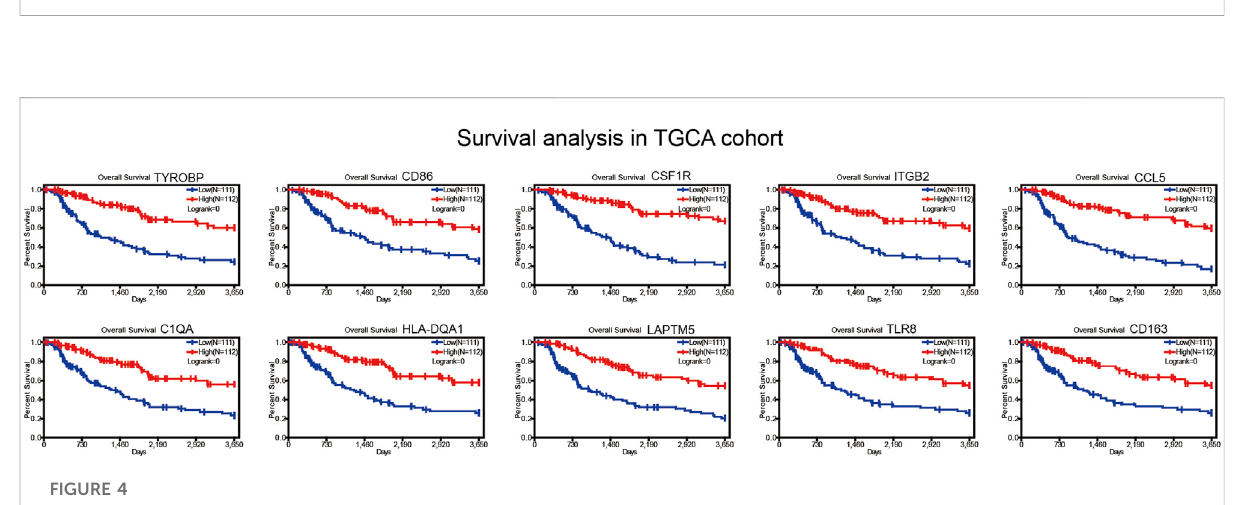
FIGURE 3 Top10GOterms(BP,MF,CC)andKEGGanalysisofoverlapDEGs( p < 0.01). (A) BPresults. (B) MFresults. (C) CCresults. (D) KEGGpathways.GO, Gene Ontology; BP, biological process; MF, molecular function; CC, cellular component; KEGG, Kyoto Encyclopedia of Genes and Genomes.